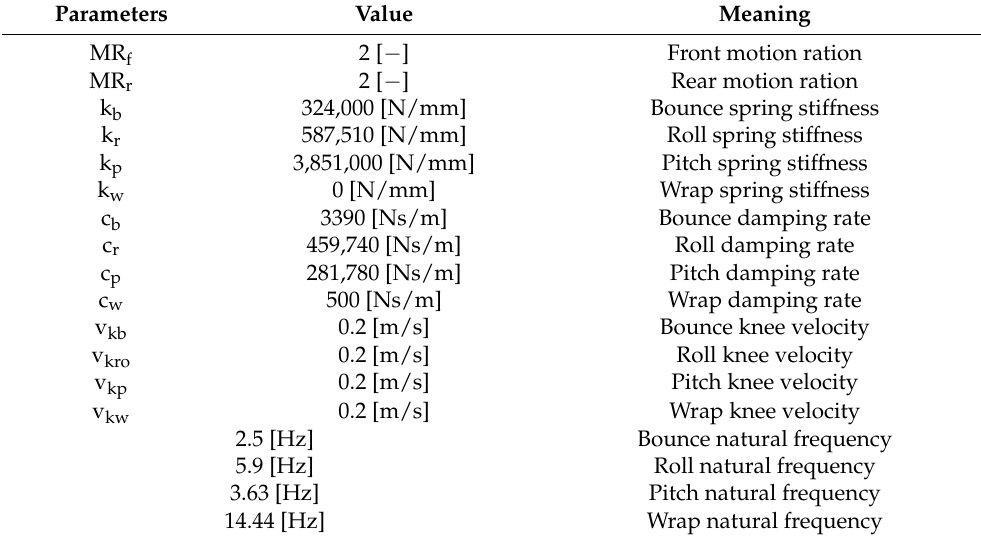
Table A3. Hydraulically Interconnected Suspension Parameters.